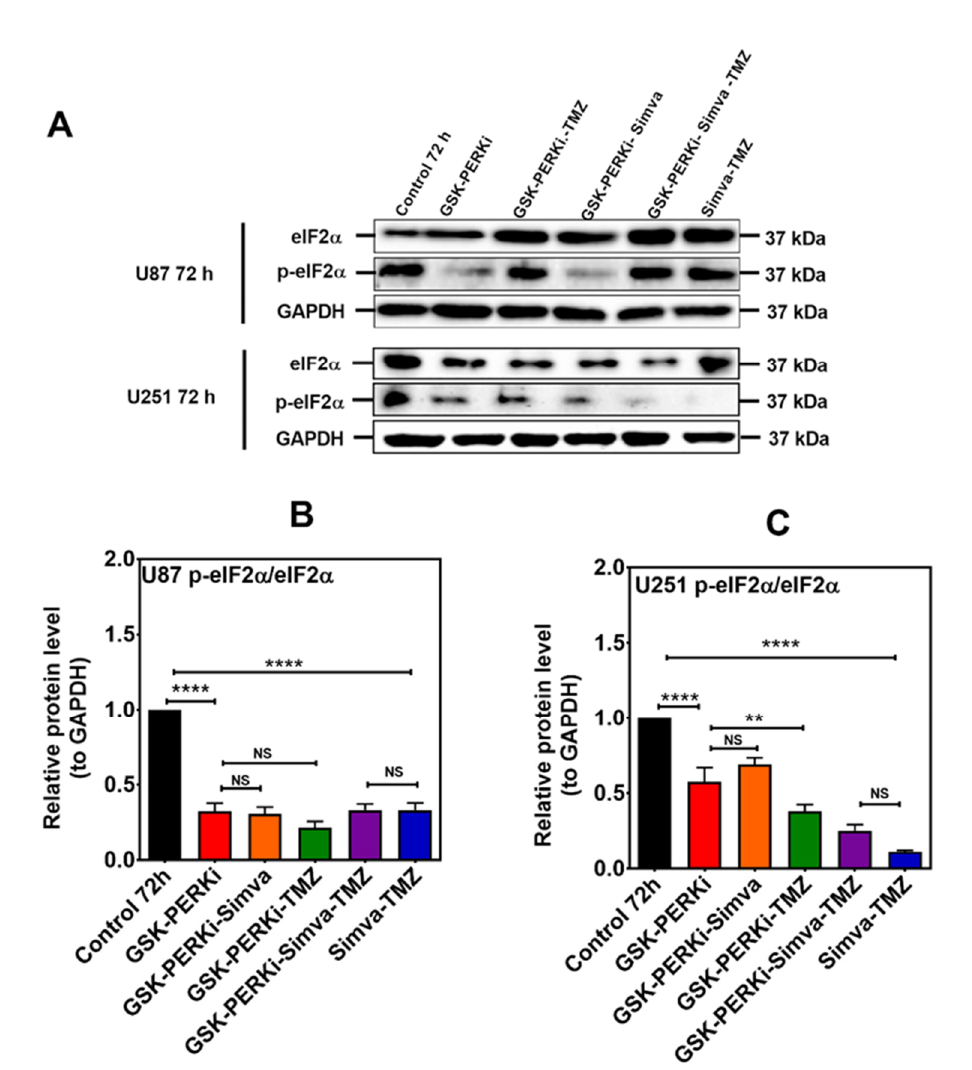
Figure 6. PERK inhibition does not change the p-eIF2 α /eIF2 α ratio in Simva–TMZ-treated cells. ( A ) U87 and U251 were pretreated with PERKi (5 µM, 30 min) and then co-treated with Simva–TMZ for 72 h. The protein levels of eIF2 α and p-eIF2 α were determined using immunoblotting; GAPDH was used as a loading control. ( B , C ) Densitometric analysis of the immunoblots showed that Simva–TMZ by itself significantly reduced the p-eIF2 α / eIF2 α ratio, which was not further decreased by the PERKi in either cell line. Of note, control levels of p-eIF2 α were significantly decreased by the PERKi as well. The data are expressed as the means ± SD of three independent experiments ** p < 0.01; **** p <